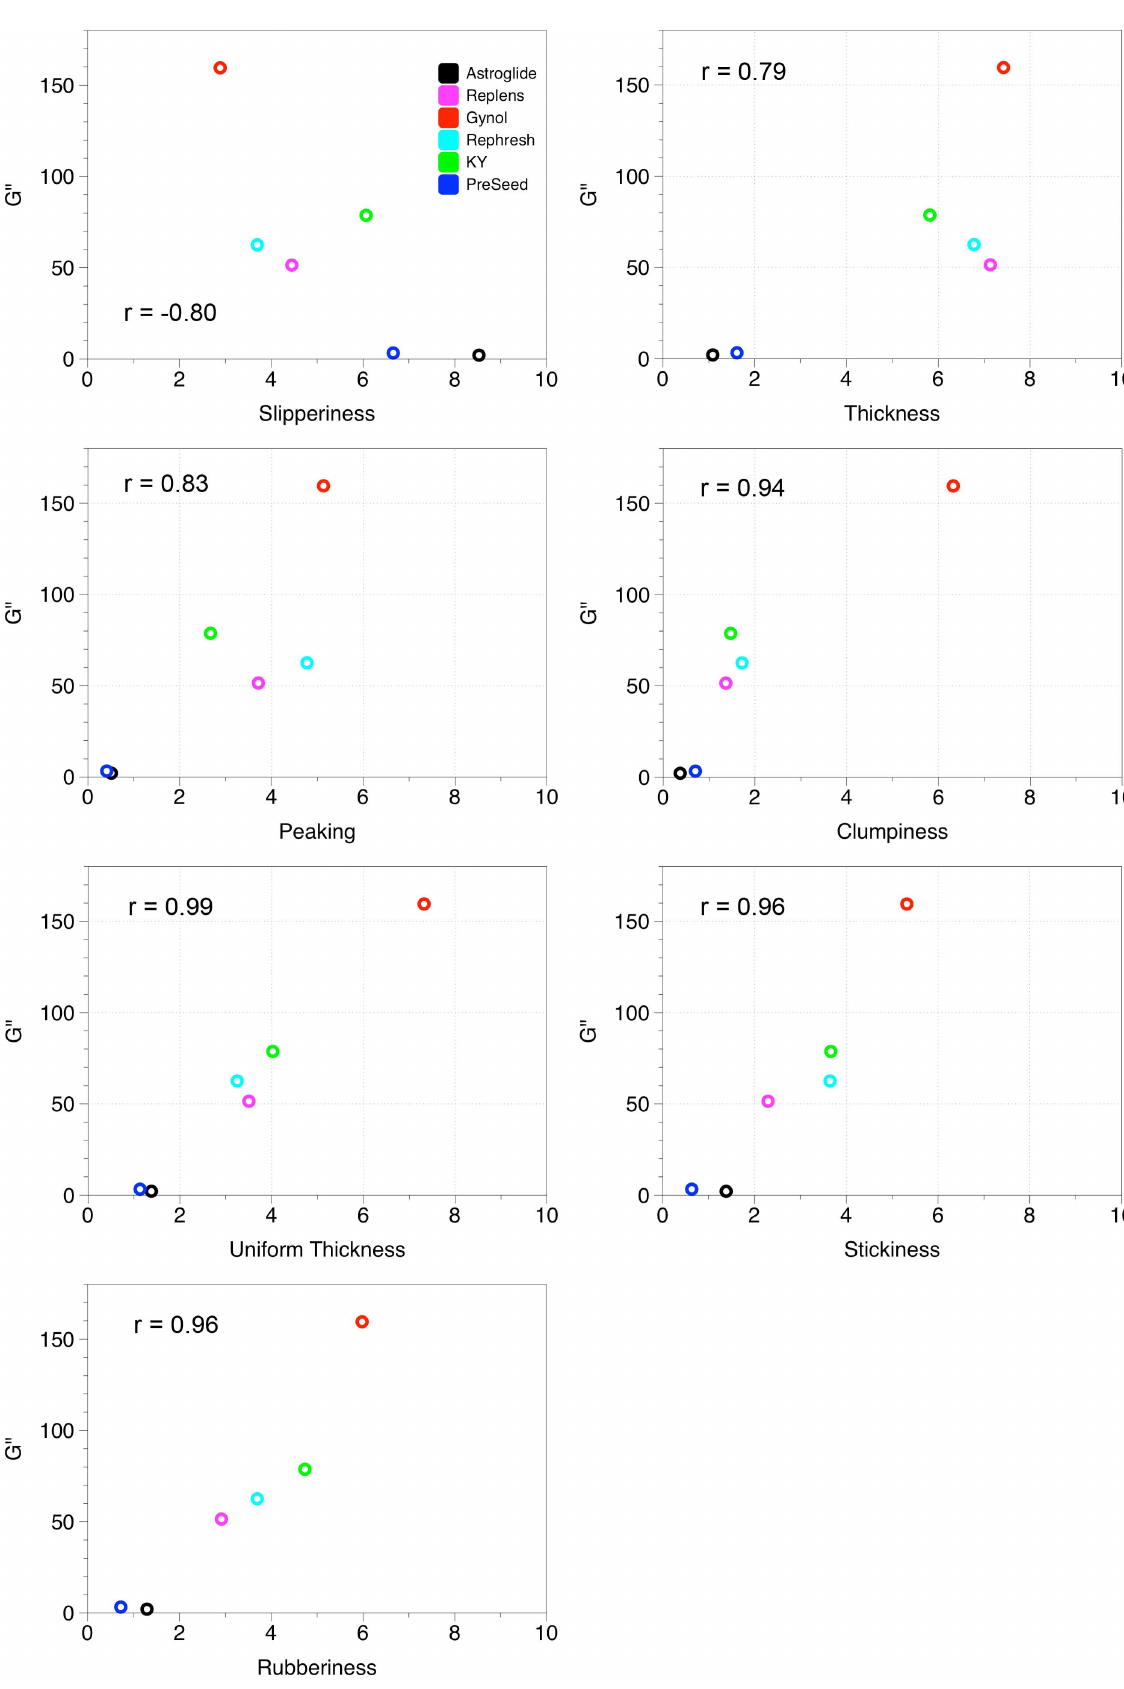
Figure 3. Individual correlations between K and sensory attributes that loaded on PC1. doi:10.1371/journal.pone.0105614.g003 PLOS ONE |